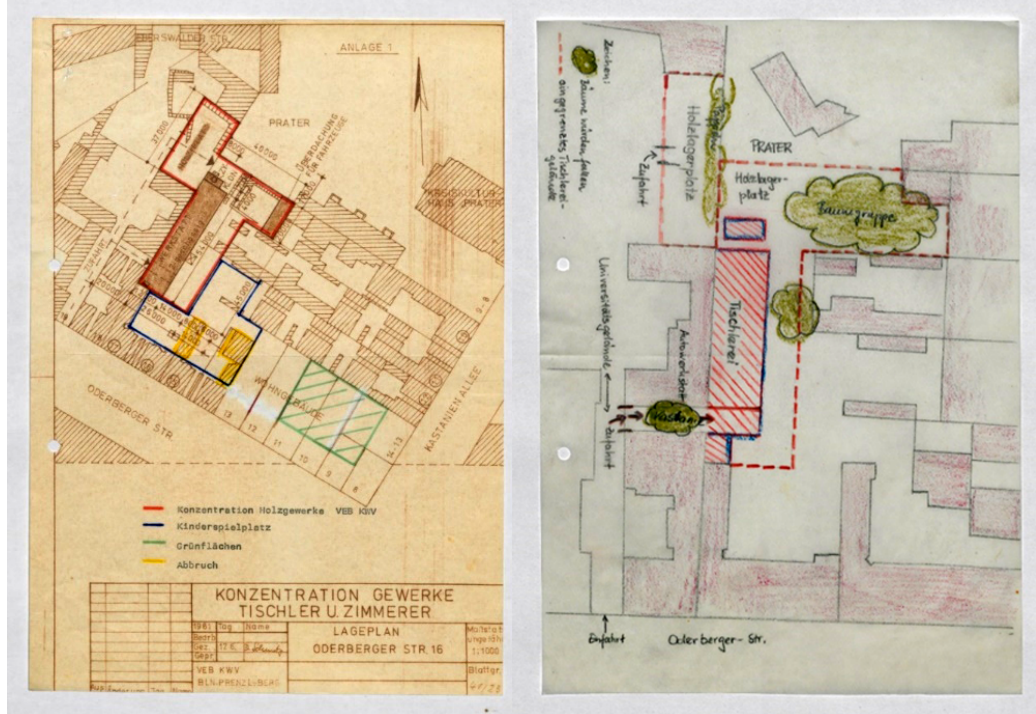
Figure 1. From left to right: Maps for the backyard conversion designed by planning authorities and neighbourhood actors. Sources: “Städtebauliche Bestätigung (Reg.-Nr. 204/81)” (1981). Image rights: Landesarchiv